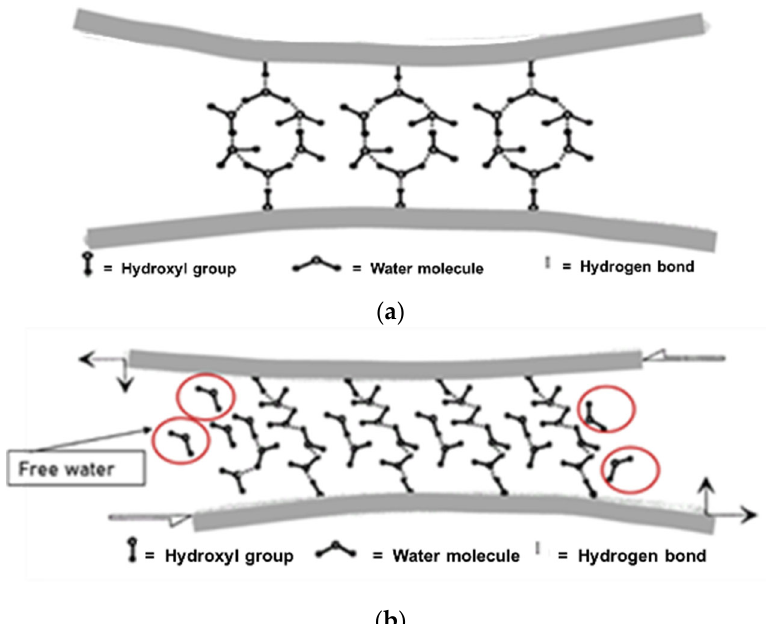
Figure 6. ( a ) C-S-H interlayer water structure. ( b ) Breaking of hydrogen bonds upon sliding between C-S-H sheets. Figure adapted from [36,37].